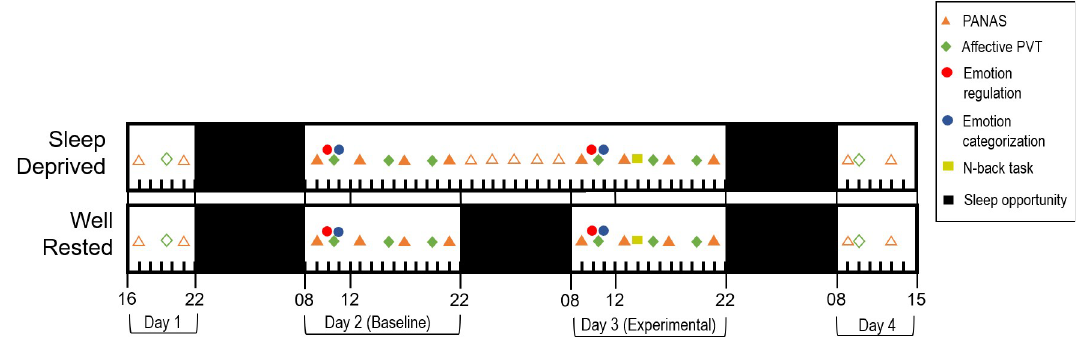
Fig 1. Study design for the total sleep deprivation condition (top) and well-rested control condition (bottom). Open symbols represent task administrations not used in